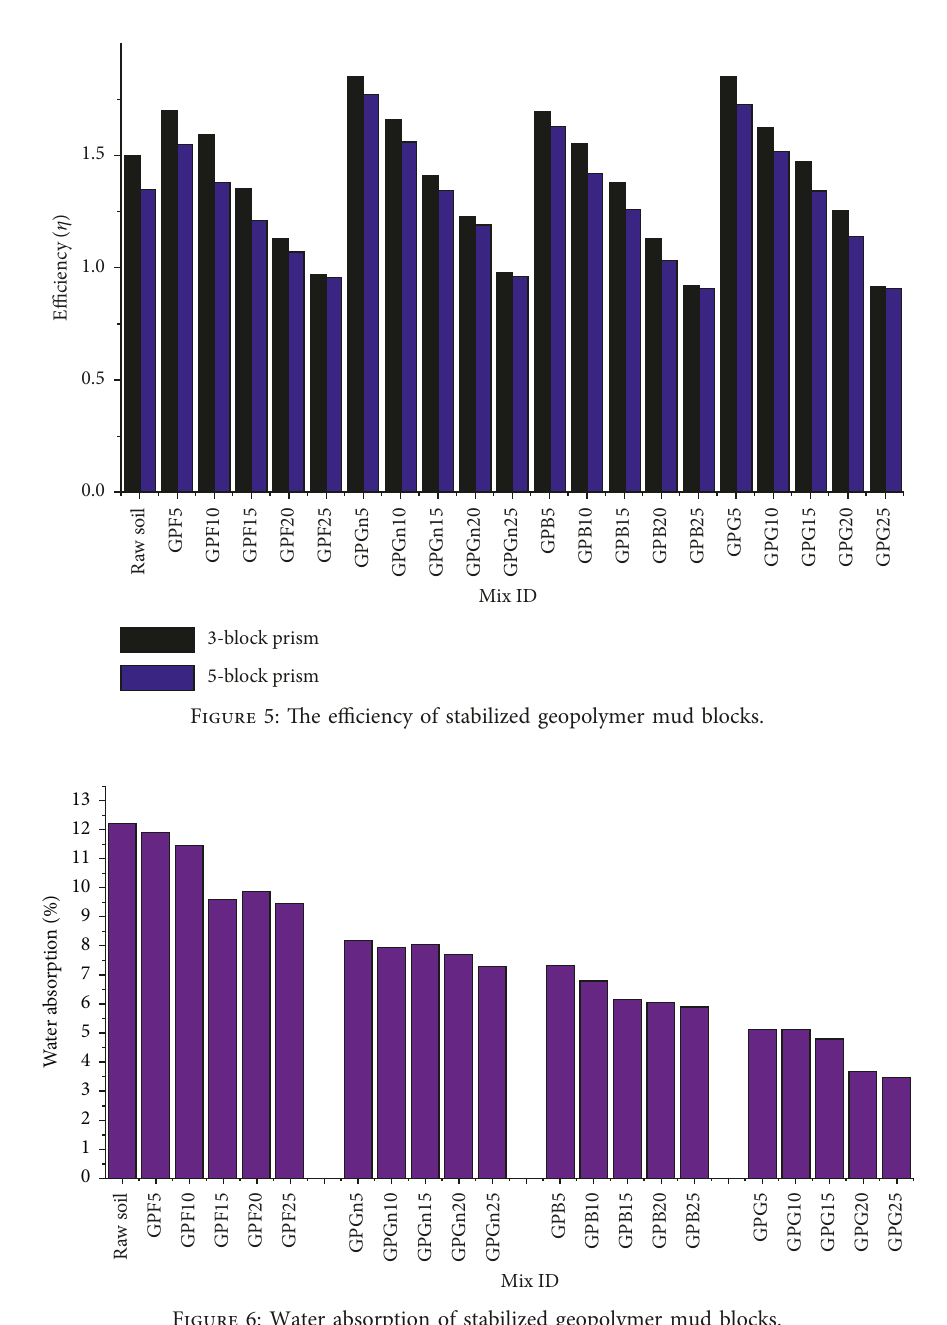
Figure 6: Water absorption of stabilized geopolymer mud